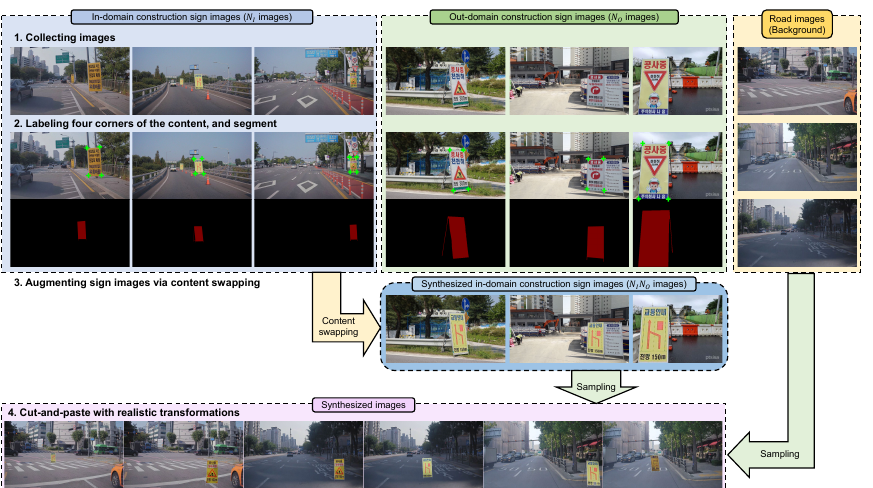
Figure 2. An overview of training data synthesis. The entire process was divided into four steps. First, we collected three types of images: in-domain construction sign images, out-domain construction sign images, and road images. Then, we labeled four corners of the contents and segmented the construction sign images. The labels were then used for content swapping. Finally, a pair of a construction image and a road image was randomly sampled and synthesized via the cut-and- paste mechanism with proposed realistic transformations. The synthesized images are used for training